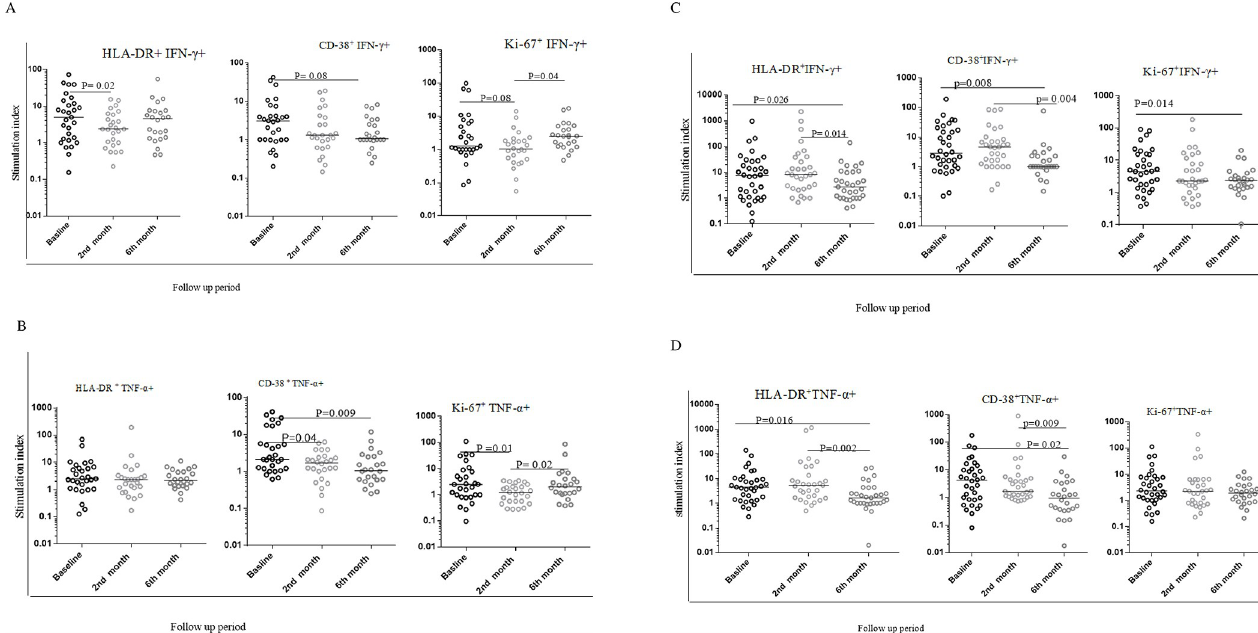
Fig 4. The level of activation and proliferation marker expression on CD4+ T cells from unstimulated PBMC samples in TB biomarkers study cohort.